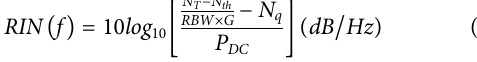
Frontiers in Materials |